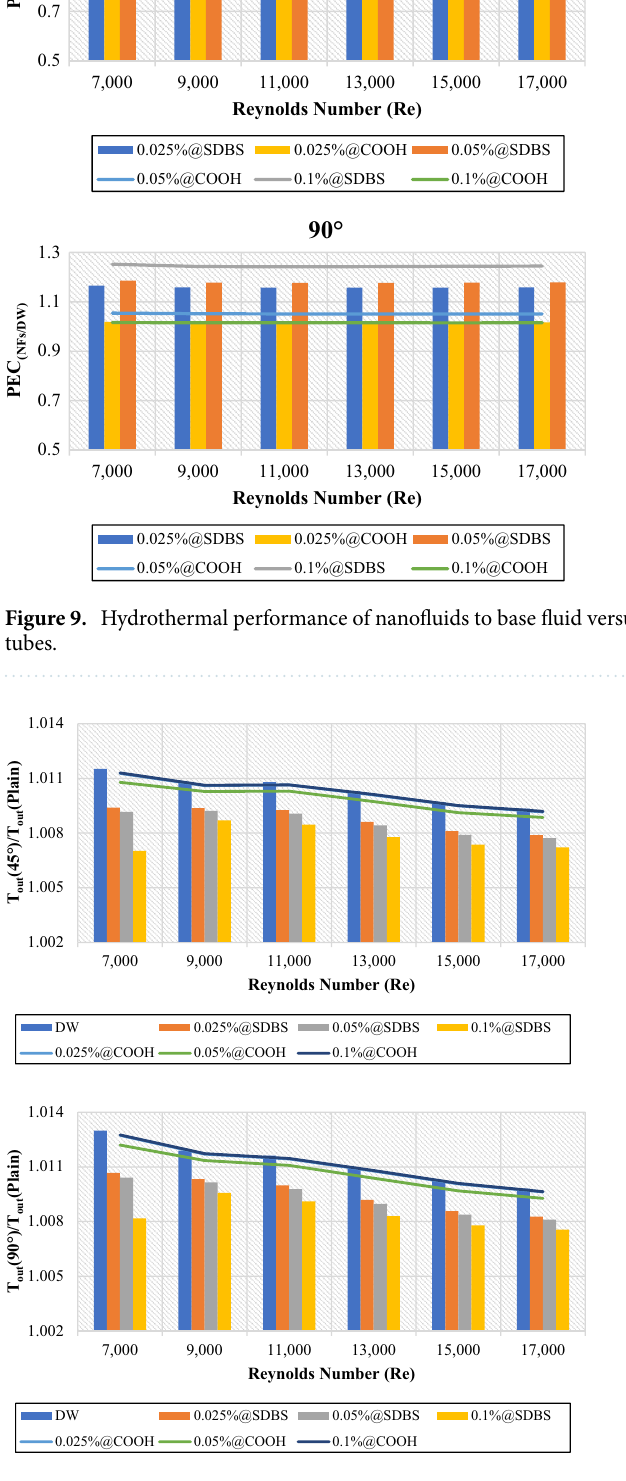
Figure 10. Outlet temperature of (45° and 90° helix angles) relative to plain pipe versus Reynolds numbers for different